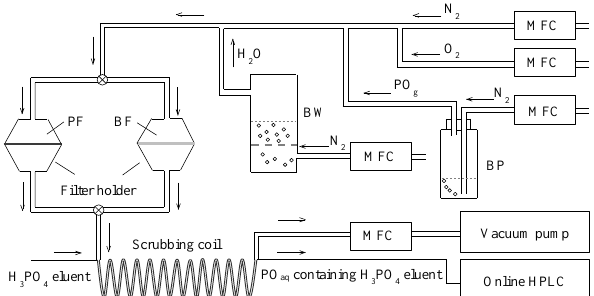
Figure 1. Schematic diagram of the experimental apparatus. MFC, mass flow controller; PF, particle-loaded filter; BF, blank filter; PO g , gaseous peroxide compound; PO aq , aqueous peroxide com- pound; BP, bubbler for peroxide vapor; BW, bubbler for water va- por; HPLC, high-performance liquid chromatography. The scrub- bing coil, BP and BW were kept in 277 and 298K water baths, respectively.